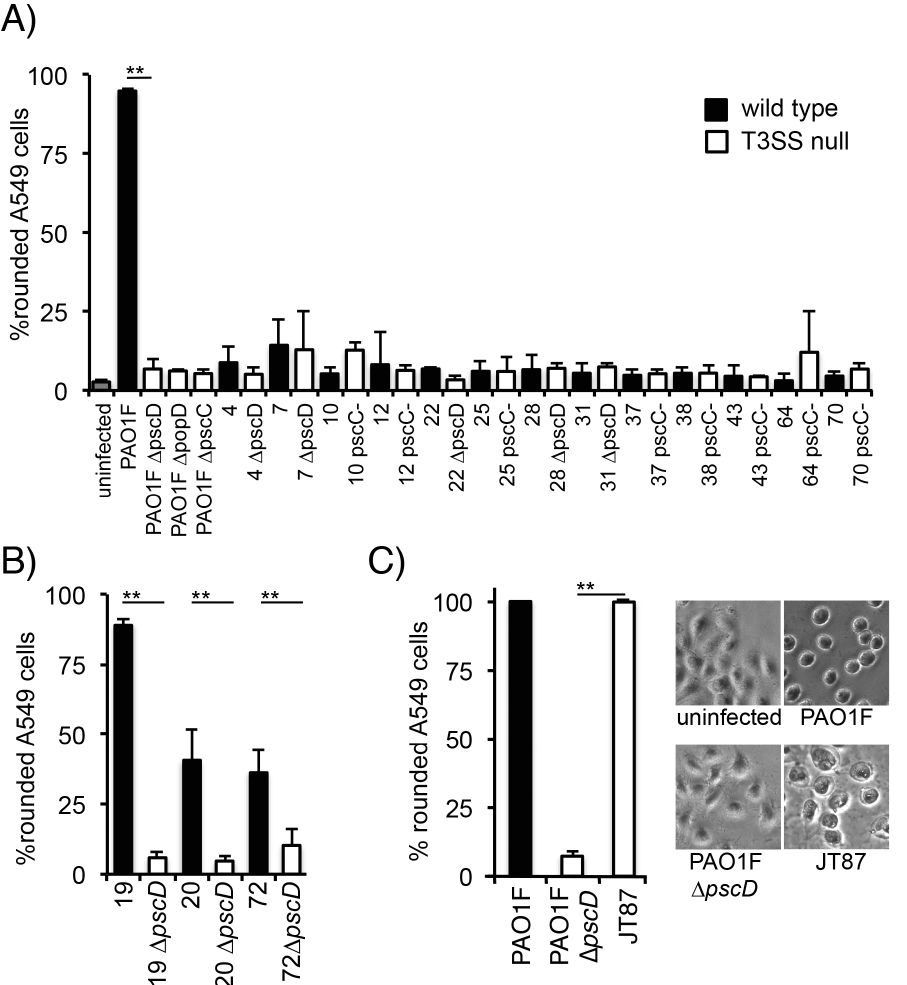
Figure 2. Intoxication of A549 lung epithelial cells by effector-negative clinical isolates of P.aeruginosa . Clinical isolates that do not secrete detectable levels of known effectors and translocators in vitro as well as defined T3SS null derivatives ( D popD , D pscD , where the entire open reading frame was removed by an in-frame deletion, or pscC -, where the pscC open reading frame was disrupted by the insertion of a non-replicating plasmid) were tested for their ability to intoxicate A549 epithelial cells in a T3SS-dependent manner. Delivery of effector proteins was measured by assaying rounding of A549 cells by microscopic examination. Data presented is the mean of three independent experiments with standard deviation (error bar). A) Isolates with no significant cytotoxicity. B) Isolates that are cytotoxic in a T3SS-dependent manner. C) Isolate JT87 has no detectable T3SS-related genes by PCR. Representative phase contrast images of A549 cells infected with PAO1, PAO1 D pscD or JT87 are shown to the right of the graph in panel C. ** p , 0.01, Student’s